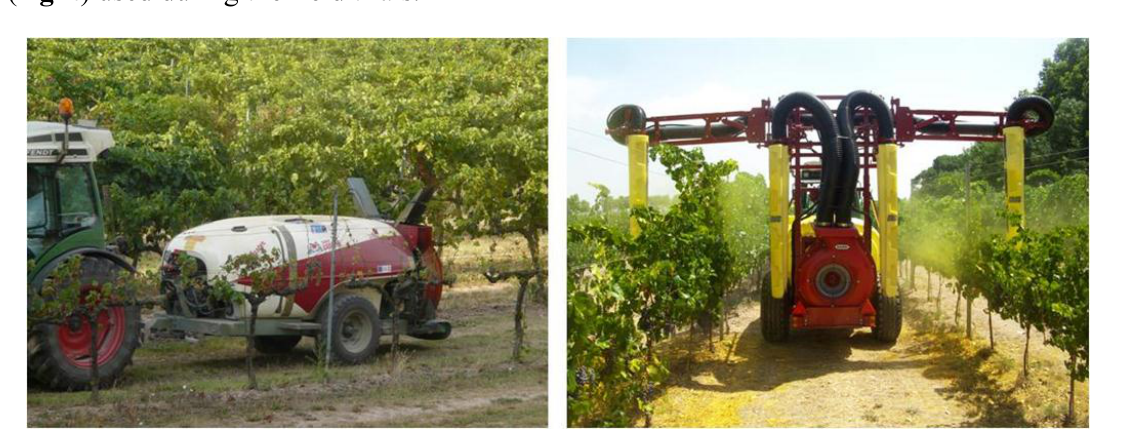
Figure 1. Conventional mistblower, Master 2000 ( left ) and multi-row sprayer, Iris-2 ( right ) used during the field trials.